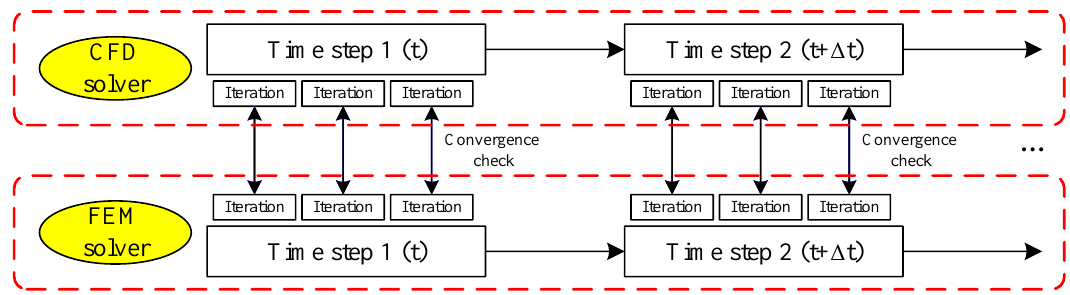
Figure 4. Framework of the implicit coupling procedure.